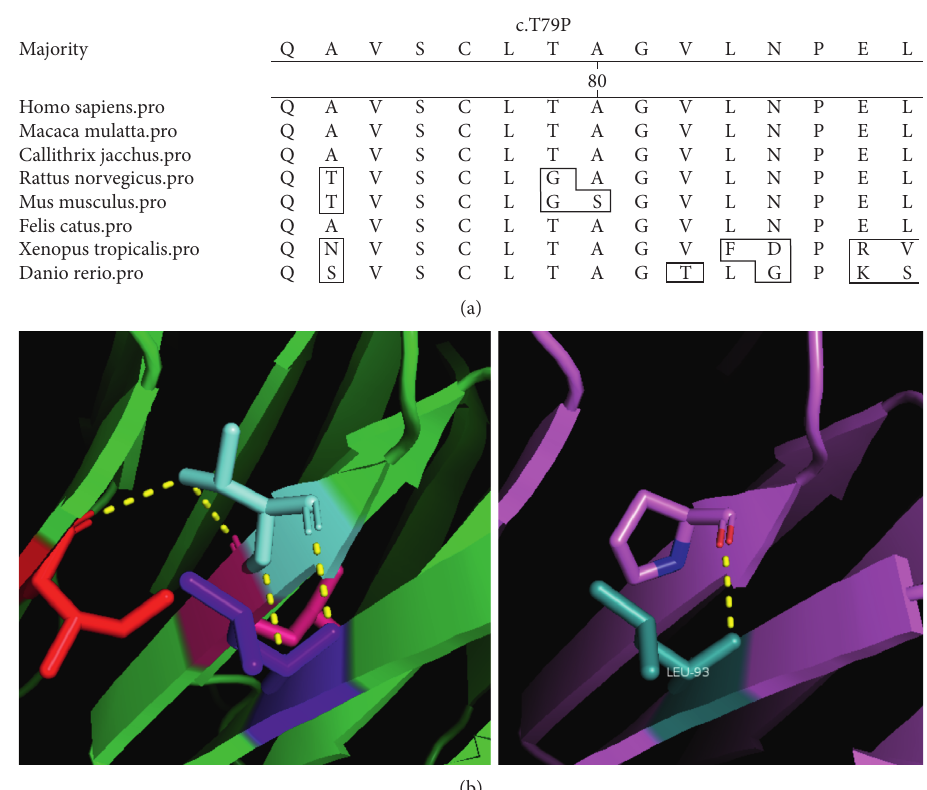
Figure 2: Conservation analysis and protein structure changes with variant p.T79P in the BBS2 gene. (a) The threonine located at position 79 is conserved residue among vertebrates. (b) The hydrophilic threonine was substituted to hydrophilic proline, causing the protein structure change.